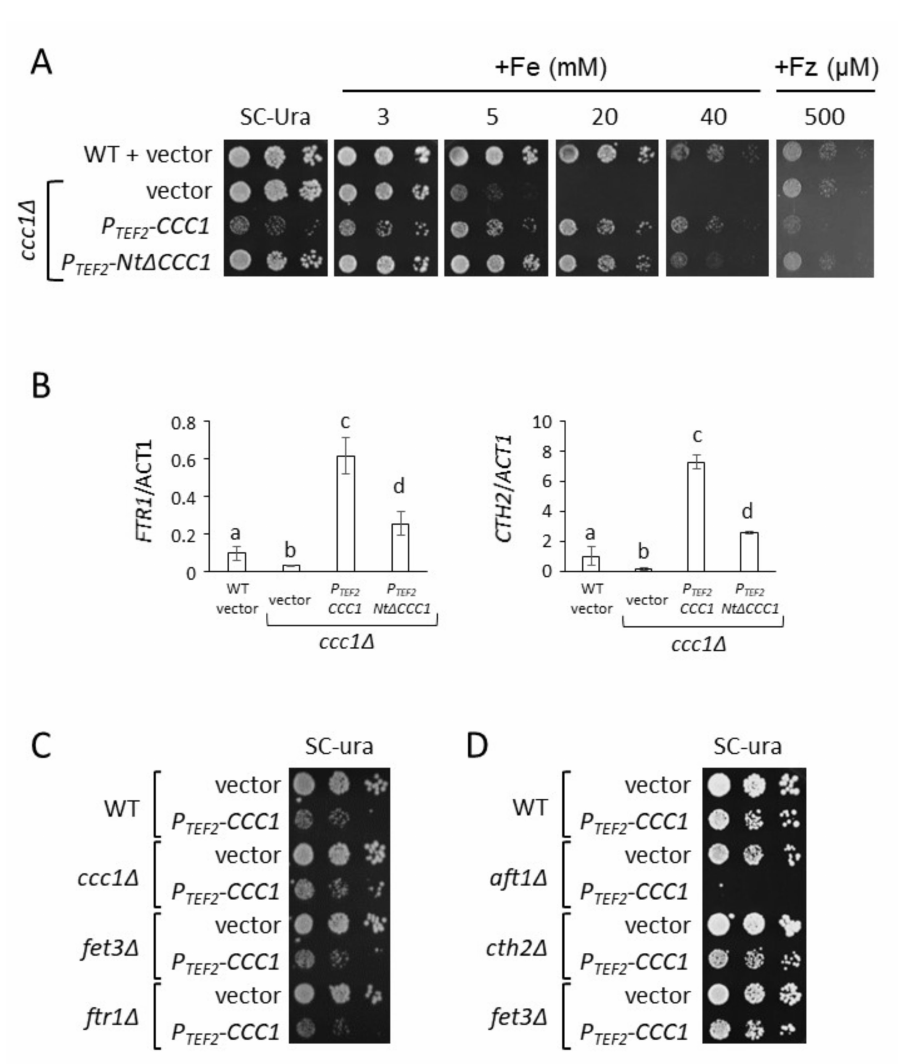
Figure 2. Toxicity of CCC1 constitutive expression under iron-sufficient conditions is rescued by iron addition or by deleting the Ccc1 cytosolic amino-terminal region. BY4741 (WT) cells were transformed with p416TEF (vector), and ccc1 ∆ cells were transformed with p416TEF (vector), p416TEF-CCC1 ( P TEF2 -CCC1 ), and p416TEF-Nt ∆ CCC1 ( P TEF2 -Nt ∆ CCC1 ) plasmids. ( A ) Expression of CCC1 altered growth in media with different iron availability. Cells were cultivated overnight in SC-Ura and then spotted on SC-Ura media containing different concentrations of FAS (Fe) or ferrozine (Fz). ( B ) FTR1 and CTH2 mRNA levels. Yeast cells were cultivated in SC-Ura + 500 µ M FAS for 6 h. Total RNA was extracted and the levels of particular mRNAs were determined by RT-qPCR. ACT1 was used to normalize data. Three independent biological replicates were performed and the average and standard deviation were determined relative to the WT. Different letters above the bars represent statistically significant differences ( p -value < 0.05). ( C , D ) Deletion of the high-affinity iron uptake system did not rescue CCC1 overexpression toxicity. BY4741 (WT), ccc1 ∆ , fet3 ∆ , ftr1 ∆ , aft1 ∆ , and cth2 ∆ cells transformed with p416TEF (vector) or p416TEF-CCC1 ( P TEF2 -CCC1 ) were spotted on SC-Ura. Plates were incubated at 30 ◦ C and